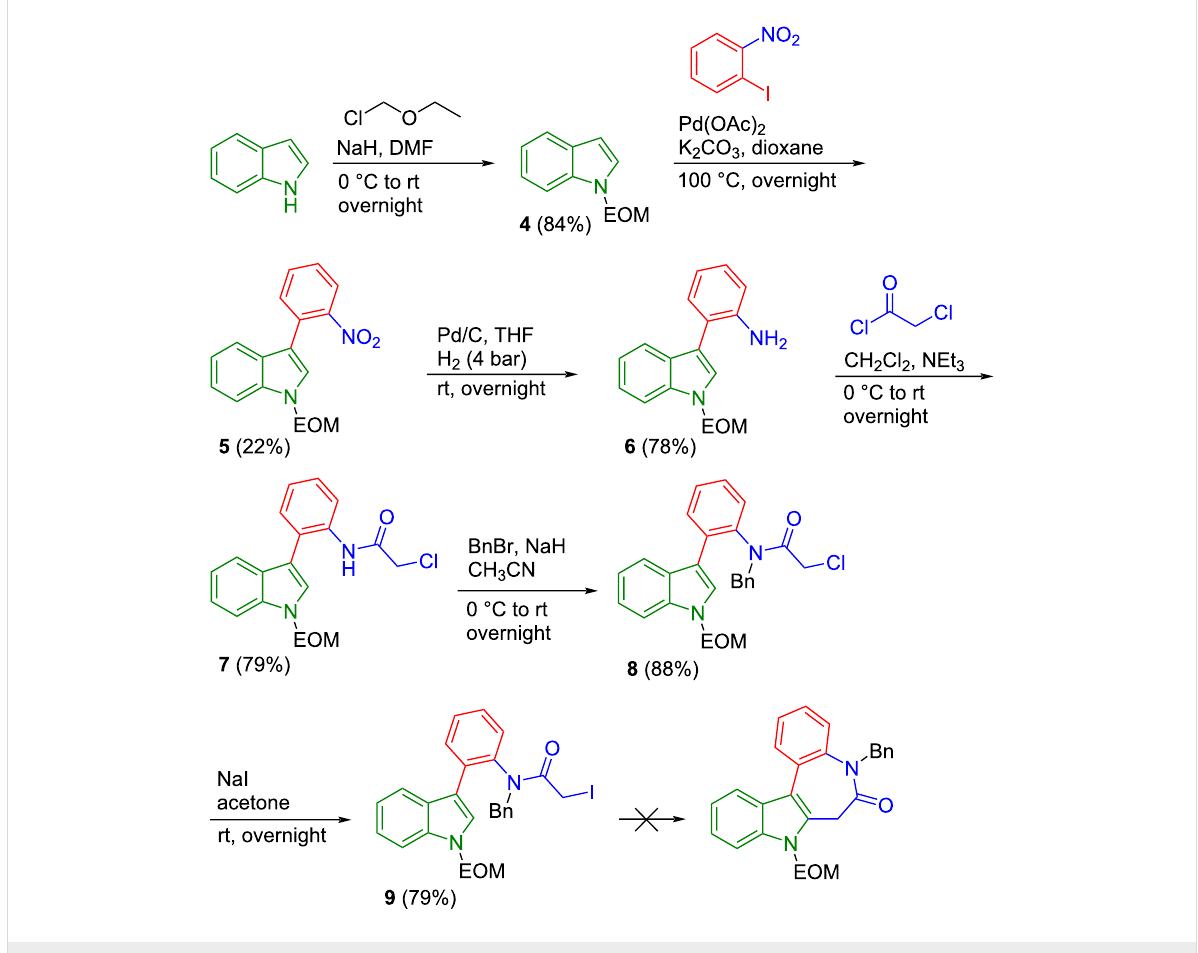
Scheme 2: Attempted synthesis of scaffold C by route